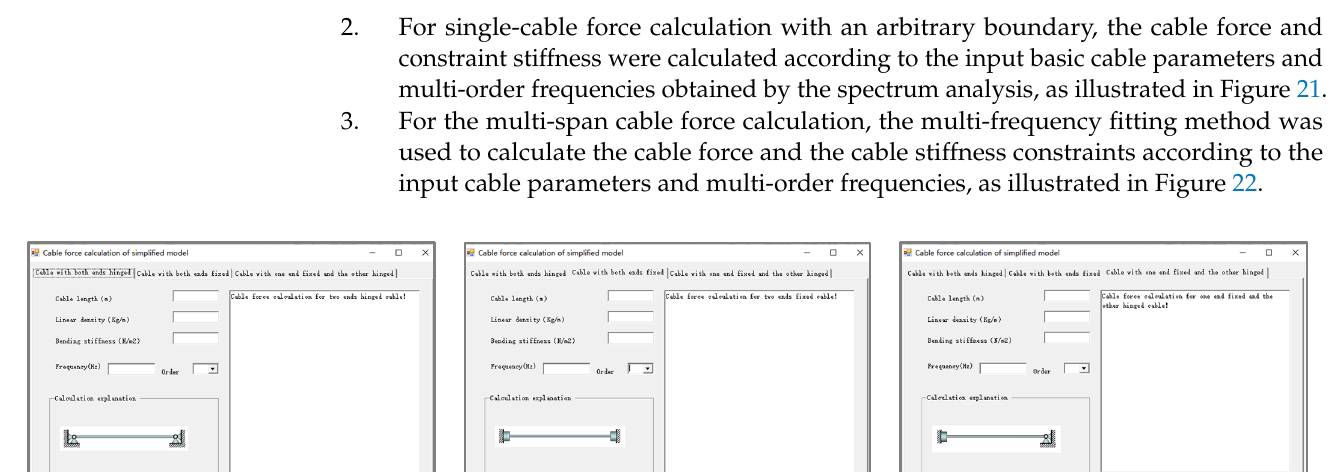
Figure 19. Software structure organization.